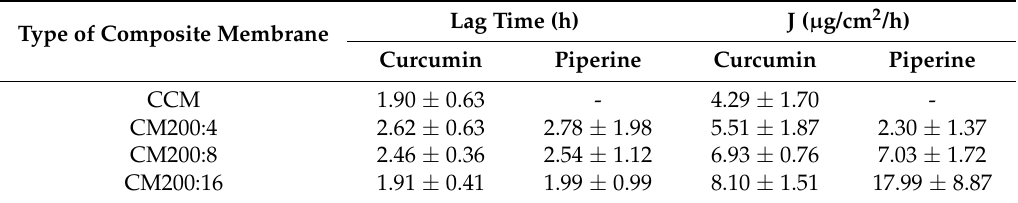
Table 3. Lag time and flux (J) of curcumin and piperine from different composite membranes compared with controlled composite membrane through mouse dorsal